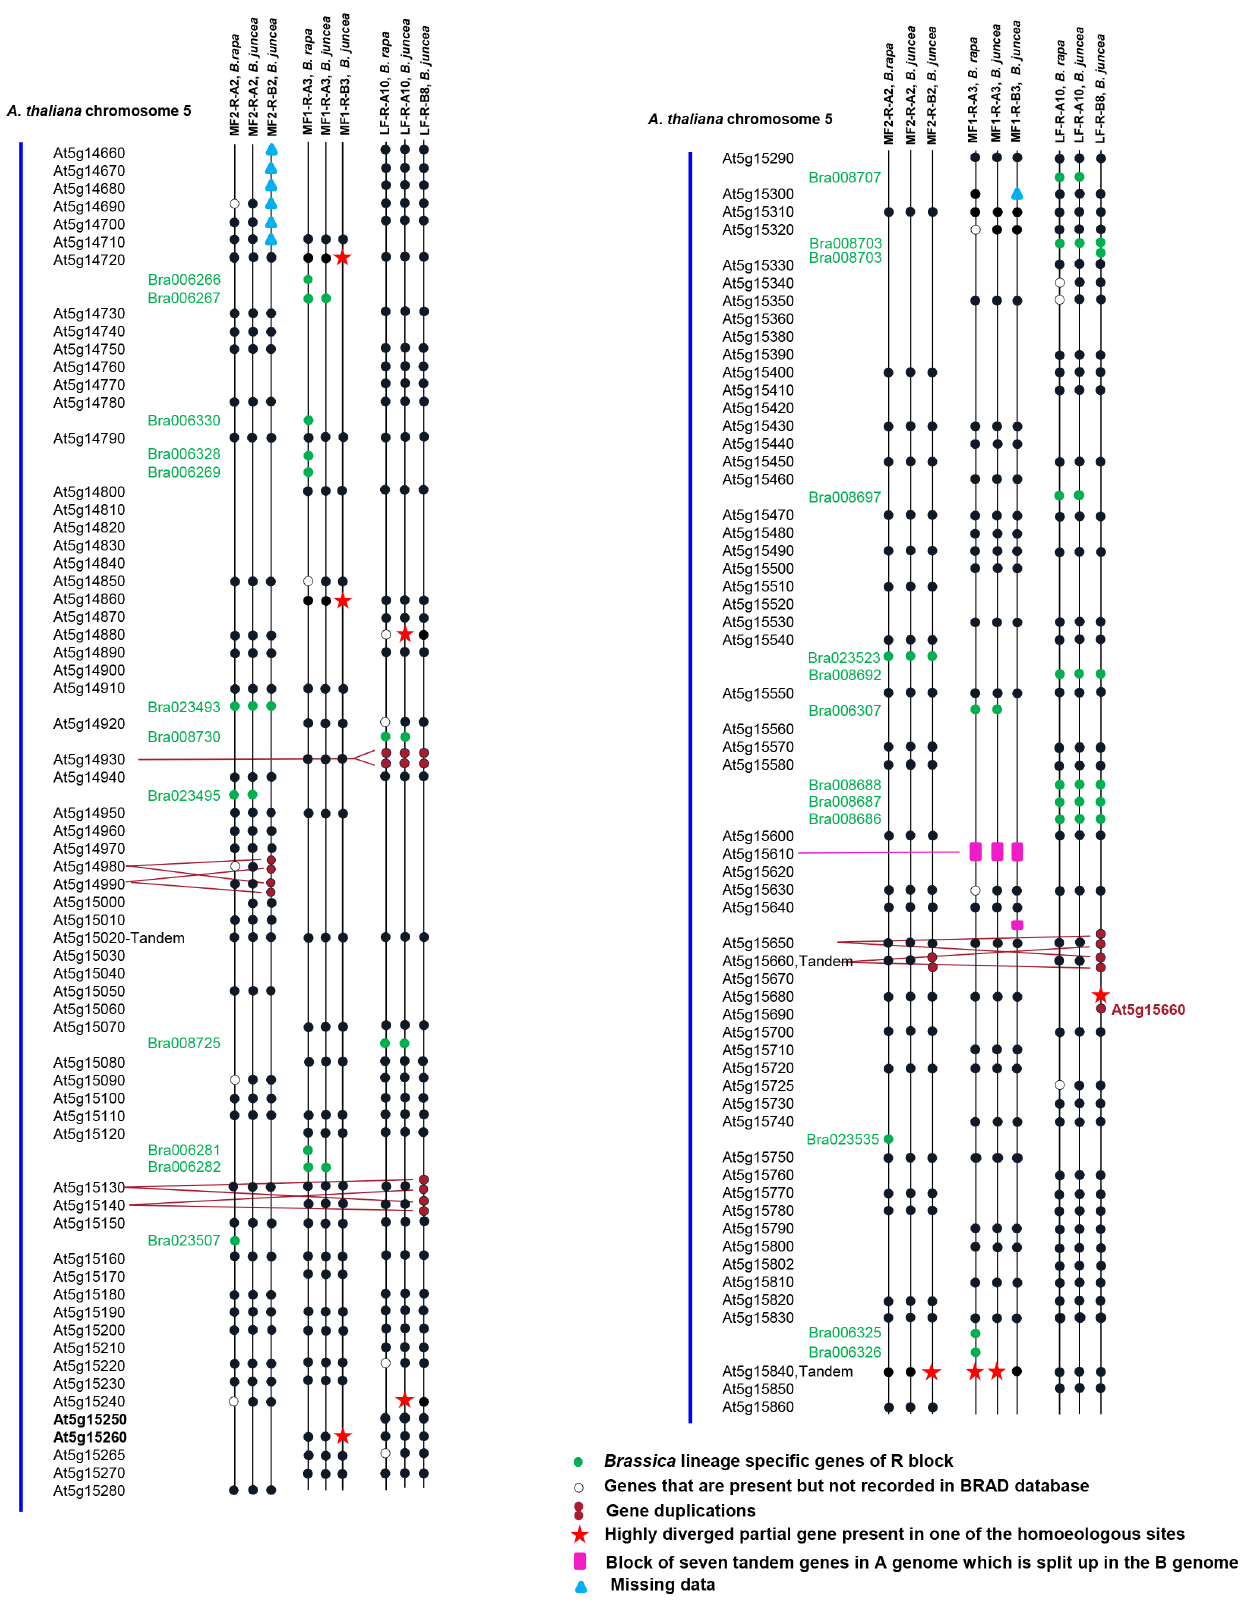
Figure 1. Comparison of the gene organisation in the six R blocks of B.juncea . Gene organisation in R blocks of the constituent A and B genomes of B. juncea has been compared with the gene organisation in the syntenous region of the R block of A. thaliana in chromosome 5 and R blocks of B. rapa . doi:10.1371/journal.pone.0093260.g001 PLOS ONE |